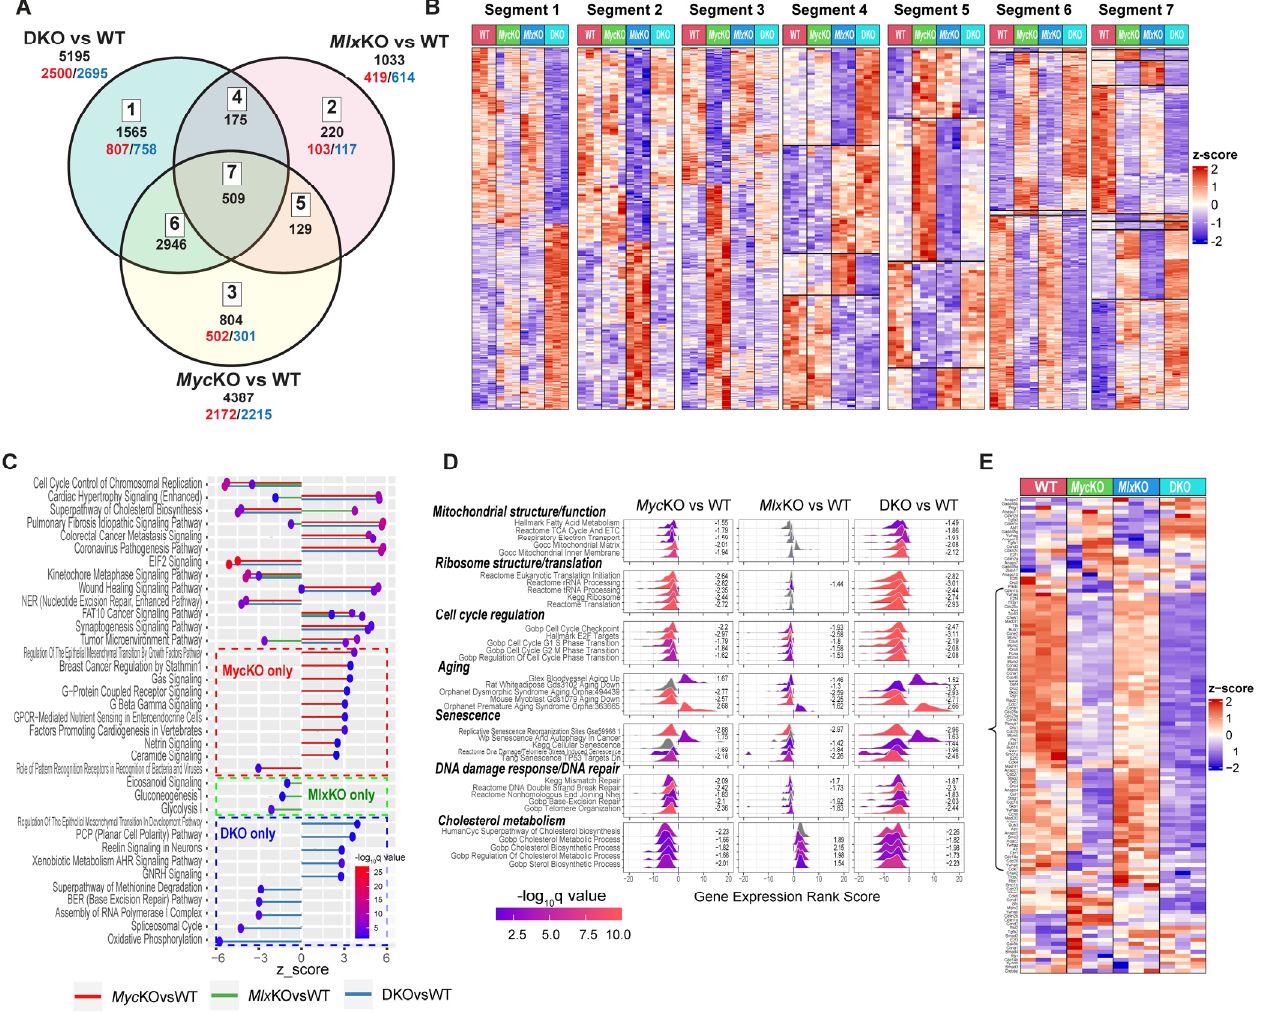
Figure 5. Transcriptional profiling of primary MEFs: ( A ) Differentially expressed transcripts in each KO group of MEFs relative to WT MEFs. Numbers within white boxes (1–7) identify specific segments of the Venn diagram referenced in the text. Numbers in black beneath these boxes indicate the total number of dysregulated transcripts in that segment relative to the WT, with those in red and blue indicating up- and downregulated transcripts, respectively. ( B ) Heatmaps of transcript groups from each of the segments shown in panel A . The results of three biological replicates of RNA-Seq experiments are shown for each of the indicated MEF groups. ( C ) IPA profiling of broad functional pathways represented by transcripts from different segments of the Venn diagram shown in ( A ). Only pathways with significant z-scores are shown. ( D ) GSEA performed with 6347 transcripts from ( A ) using the Enrichr database collection [22]. ClusterProfiler was used to display representative examples of the gene sets within each general category using the ridgeline plot application tool [21]. See Figures S3–S9 for additional GSEAs from each of these broad categories. ( E ) Heatmap of individual transcripts from the 121-member KEGG_CELL_CYCLE gene set taken from the “Cell Cycle Regulation” category in ( D ). The bracket indicates a transcript subset that